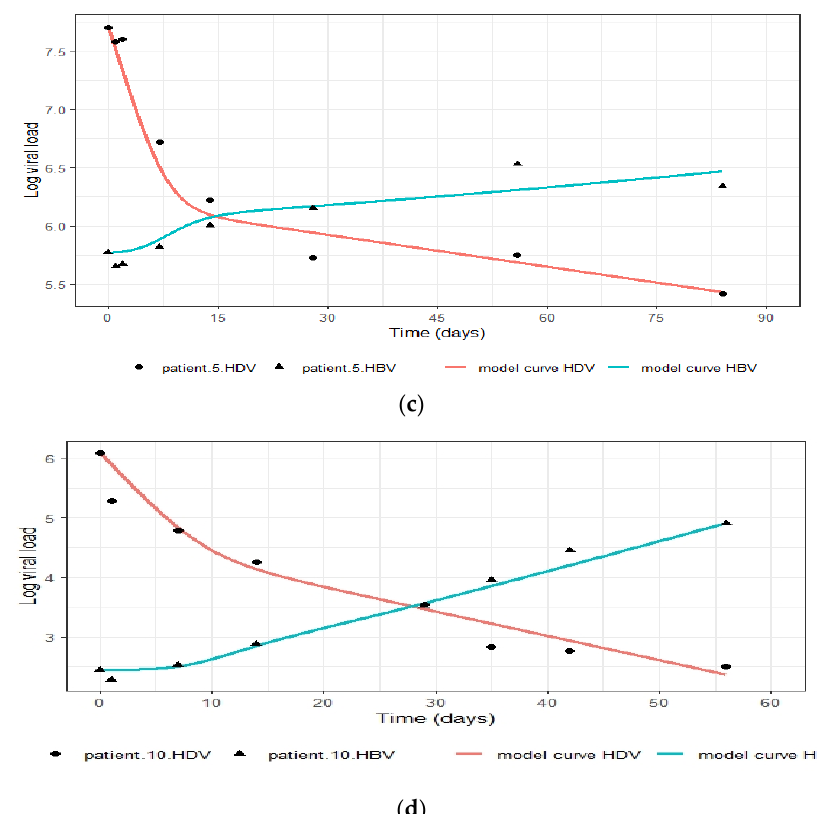
Figure 4. Model agreement with measured HDV RNA (circles) and HBV DNA (triangles) kinetics in four representative patients. Model parameters were ( a ) B 0 = 30,200, D 0 = 1.14815 × 10 6 , ε = 0.53, g = 0.077, n = 1.8, and κ = 9799, ( b ) B 0 = 151, D 0 = 6.30957 × 10 5 , ε = 0.97, g = 0.054, n = 2, and κ = 25,503, ( c ) B 0 = 5.88844 × 10 5 , D 0 = 5.01187 × 10 7 , ε = 0.97, g = 0.020, n = 1.1, and κ = 1.23198 × 10 6 , and ( d ) B 0 = 282, D 0 = 1.20226 × 10 6 , ε = 0.97, g = 0.094, n = 1.25, and κ = 26,137. The other model parameters c and τ were fixed to 0.47 and 0.1, respectively, except for Patient 2 with τ = 0.6, as depicted in Figure 4a.